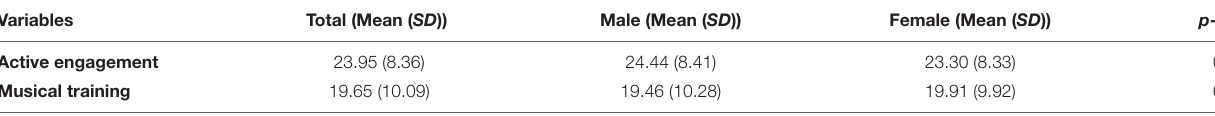
TABLE 2 | Gold-MSI results for active engagement and musical training subscales in all participants and each gender separately.